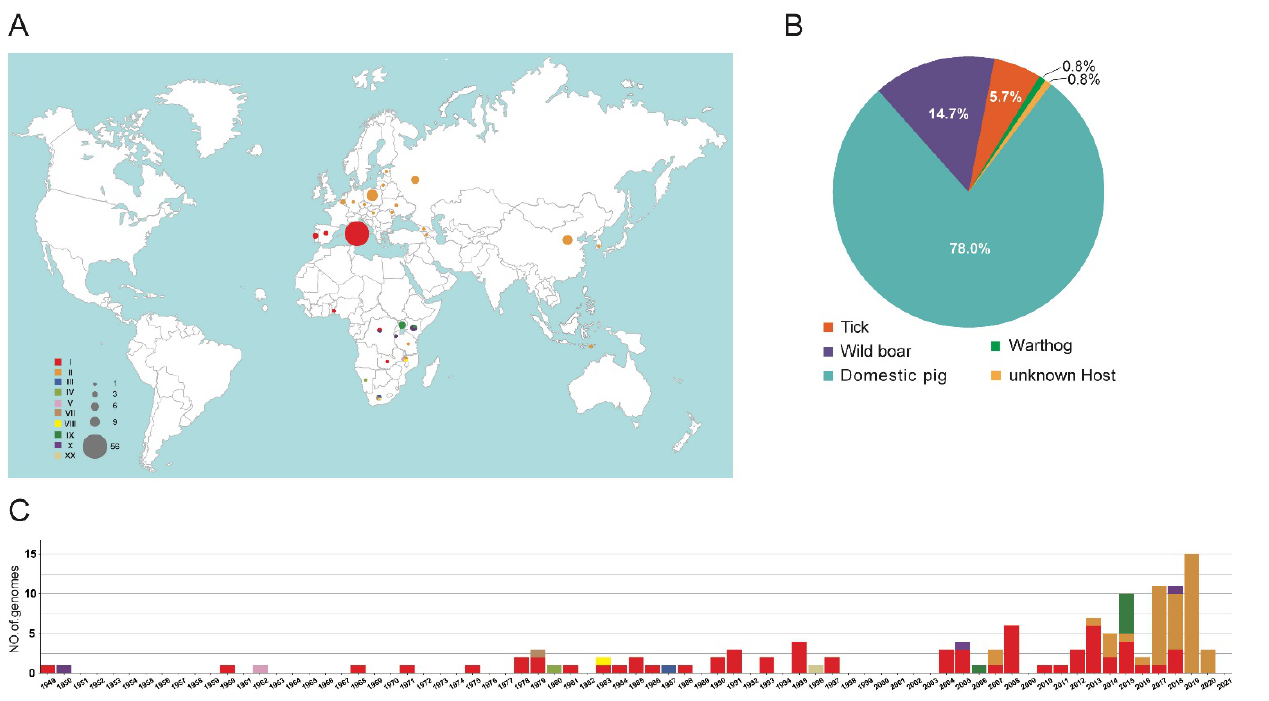
Figure 1. Distribution of African swine fever virus genome sequences included in the curated dataset. ( A ) Map indicates the collection locations of the ASFV genome sequences. ( B ) Distribution of the host of the ASFV genome sequences. ( C ) Distribution of the collection date of the ASFV genome sequences.